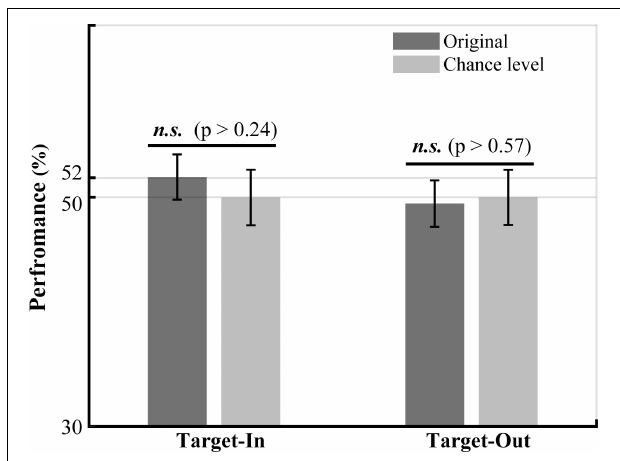
FIGURE 6 | The performance of LFP power in the high-gamma frequency band (190–210 Hz) in decoding the fast and the slow trials. The LFP power in the high-gamma frequency band was calculated for the fast and the slow trials using the Welch method (see Materials and methods). The bounds of high-gamma frequencies (i.e., 190 to 210 Hz) were defined based on the frequency ranges in Figure 5 with a high concentration of bifrequency components. We normalized the high-gamma power to the average high-gamma power at each site. The performance of the high-gamma power for decoding the fast and the slow trials was calculated by employing a k -Nearest Neighbor classifier. We used a repeated holdout method (100 times) to subdivide the trials into the training and the test subsets. In each repetition, we used 70% of the trials for training and the remaining trials for the test. The chance level was calculated for each target position condition by repeatedly (100 times) shuffling the trials between the fast and the slow groups. The result clearly indicates that the decoding performance of high-gamma power is not significantly different between the original and the shuffled high-gamma power in each target position condition (permutation test, p > 0.05). The p -values have been shown on top of the bars.